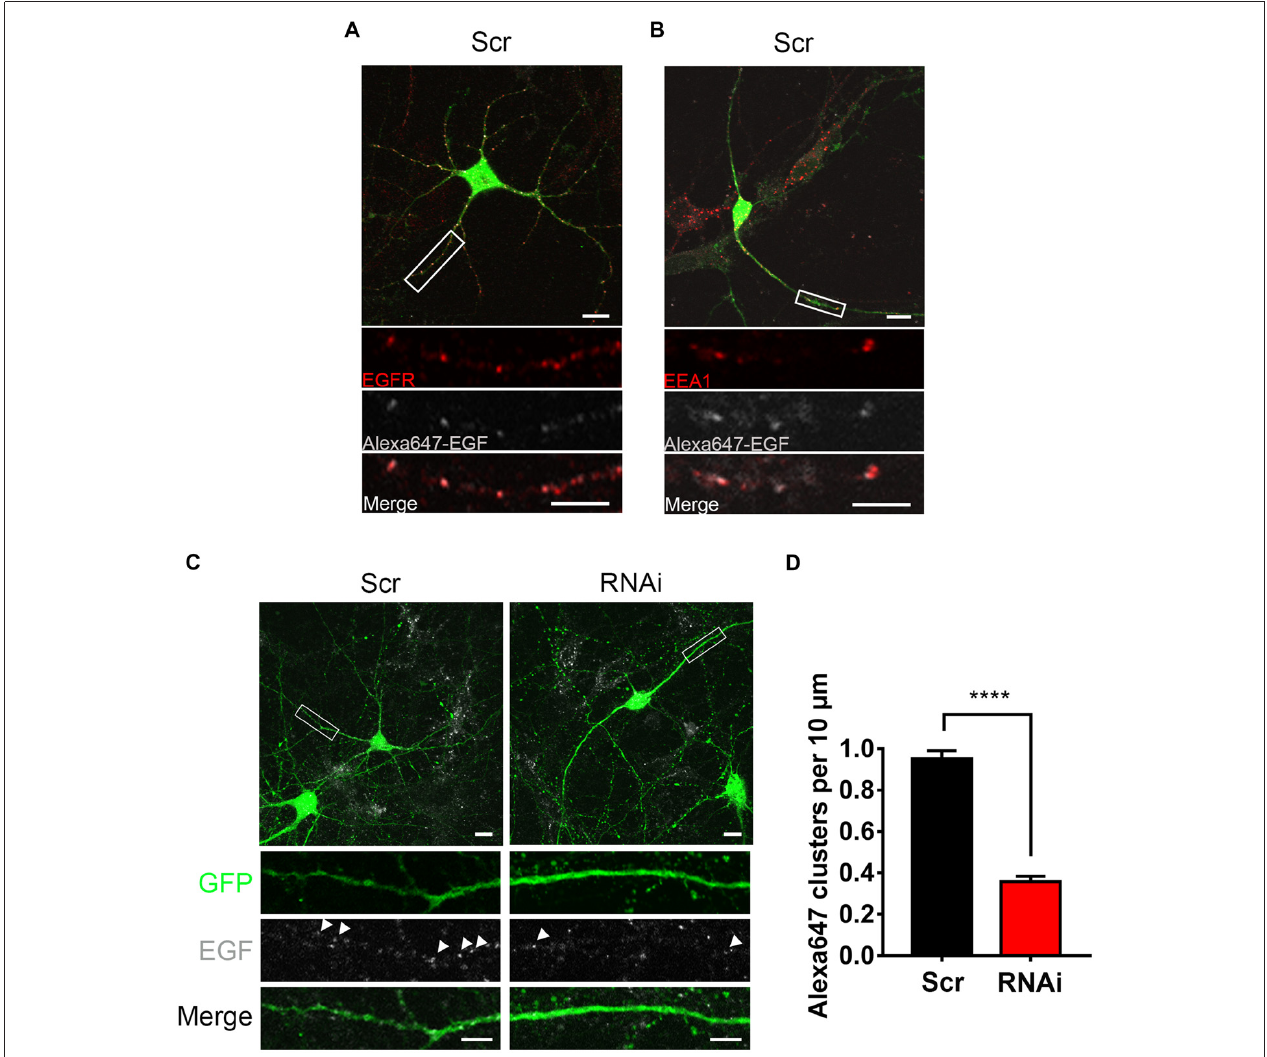
FIGURE 5 | HIP1R knockdown affects the internalization of EGF. (A) Representative images of control neurons after a 20 min-treatment of Alexa 647 -EGF stained against EGFR (red). GFP (green) and Alexa 647 -EGF (gray). Scale bar, 20 µ m. (B) Representative images of Alexa 647 -EGF treated control neurons stained against EEA1 (red). GFP (green) and Alexa 647 -EGF (gray). Scale bar, 20 µ m. (C) Representative images of Alexa 647 -EGF treated control and knockdown neurons. Scale bar, 20 µ m. (D) Quantification of EGF clusters ( n = 73 neurons for Scrambled and 51 neurons for RNAi). Mean ± SEM; ∗∗∗∗ p < 0.0001; three independent experiments; unpaired two-tailed t